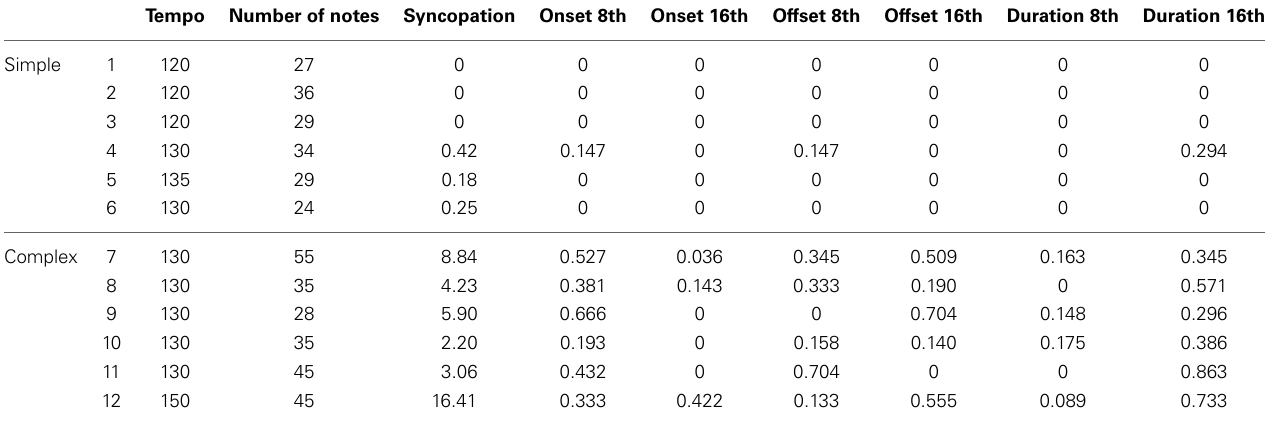
Table 1 | Descriptive statistics and performance parameters for the deadpan versions of each